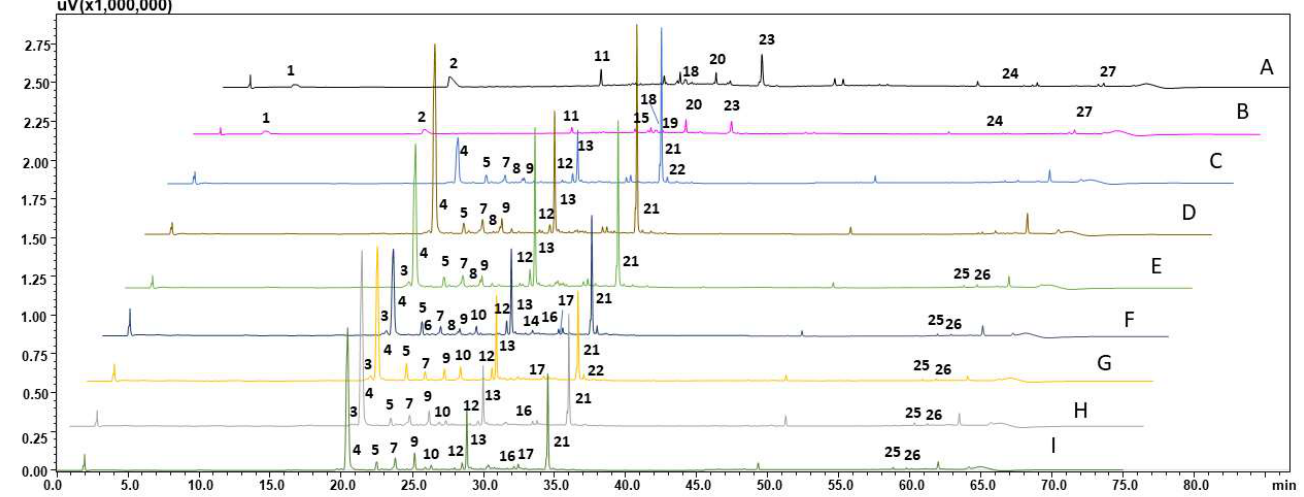
Figure 6. HPLC-PDA-ESI-MS chromatograms of methanolic extract derived from hairy roots cultivated under various culture conditions: ( A ) control roots collected after 10 days of culture; ( B ) control roots collected after 20 days of culture; ( C ) control roots collected after 30 days of culture; ( D ) control roots collected after 40 days of culture; ( E ) control roots collected after 50 days of culture; ( F ) hairy roots elicited for 3 days with 50 µM MeJA; ( G ) hairy roots elicited for 7 days with 100 µM MeJA; ( H ) hairy roots elicited for 1 day with 100 µM MeJA 100 and then transferred to control medium for 30 day cultivation; ( I ) hairy roots elicited for 7 days with 100 µM MeJA 100 and then transferred to control medium for 30 day cultivation.